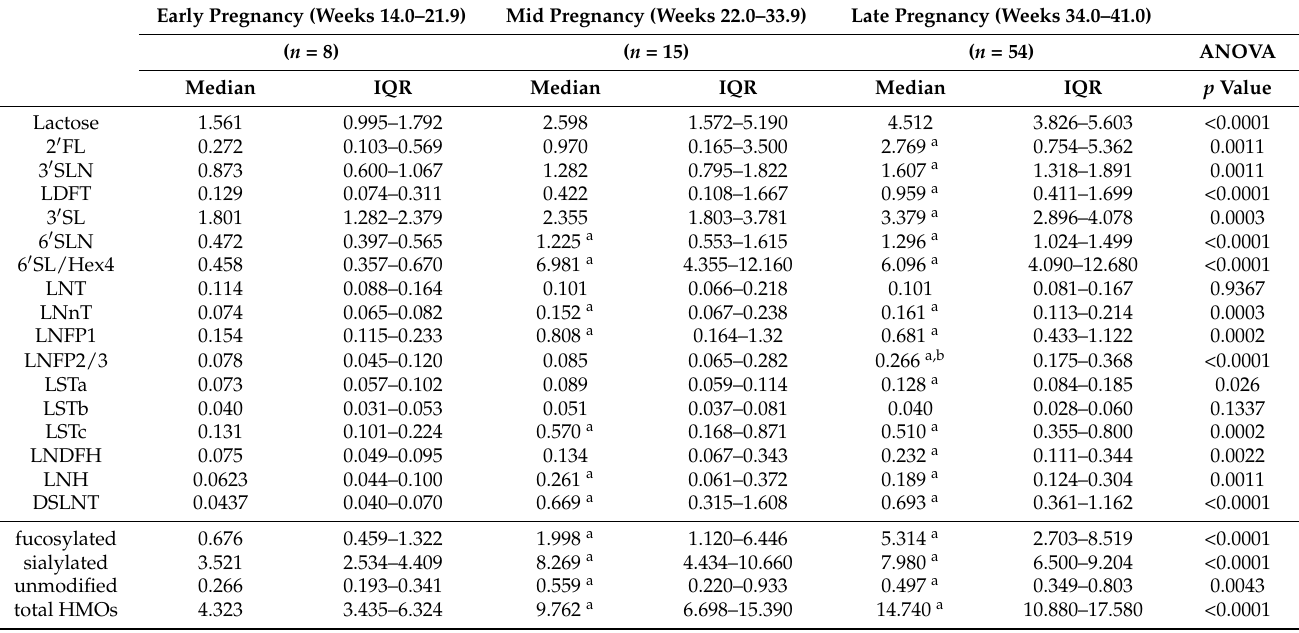
Table 2. Lactose and HMO concentrations in amniotic fluid during pregnancy